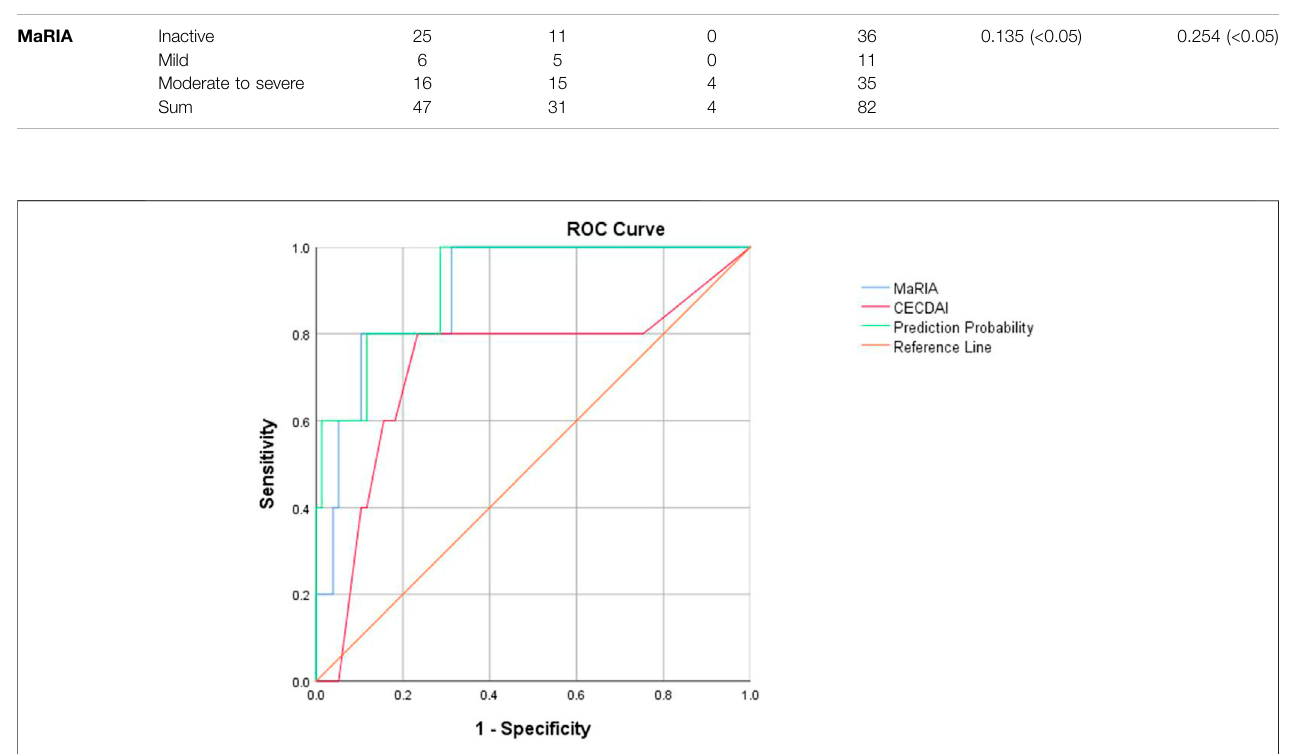
FIGURE 4 | ROC curves of MaRIA, CECDAI, and their combined applications to evaluate clinical activity in children with Crohn ’ s disease.